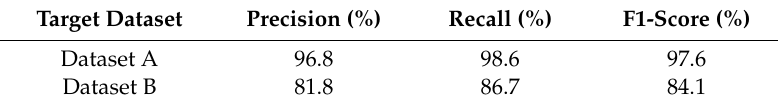
Table 3. Results of two target datasets with Scenario 2.